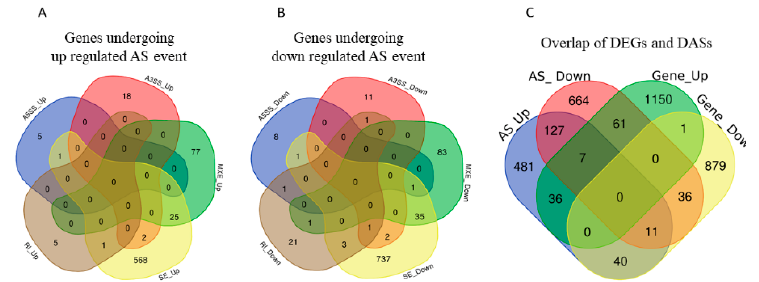
( Traf3ip1 and Abhd14b) and down ( Asic5 and Kif1a) exon skipping events in pregnant and non-pregnant UA are presented in Figure 8.